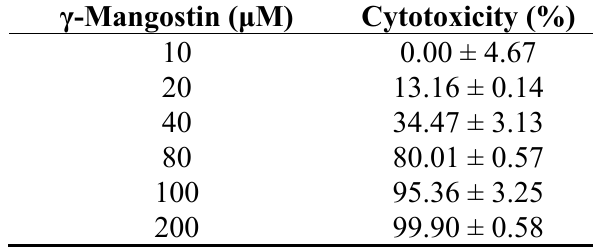
Data shown as mean ± SD, n = 3.